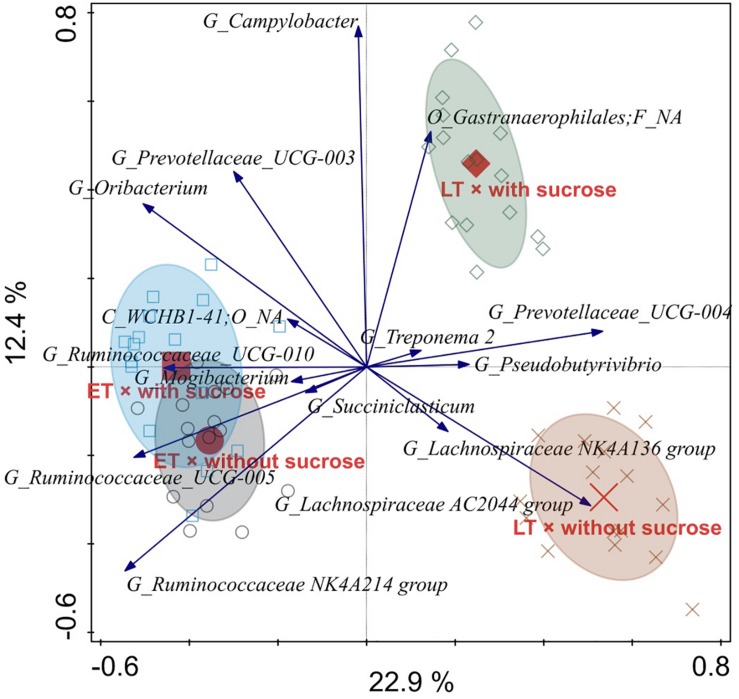
Redundancy analysis triplot illustrating the relationship between the top 15 genus-level phylogenetic groupings of the operational taxonomic units (OTU) for liquid-associated microorganisms explaining the variance of the interaction of time point × sucrose addition with the covariates vessel and experimental run. Arrow length indicates the variance that can be explained by the interactions. Arrow labels indicate the taxonomic identification of genus-level phylogenetic groupings, with the level [i.e., phylum (P), class (C), order (O), family (F), or genus (G)]. Abbreviation NA indicates the levels that could not be annotated, for instance “O_Gastranaerophilales; F_NA” was reliably assigned to the order Gastranaerophilales, but the family could not be annotated. Sample codes for the means indicate the different time points, i.e., early (ET) and late (LT), as well as the sucrose addition, i.e., with sucrose or without sucrose.